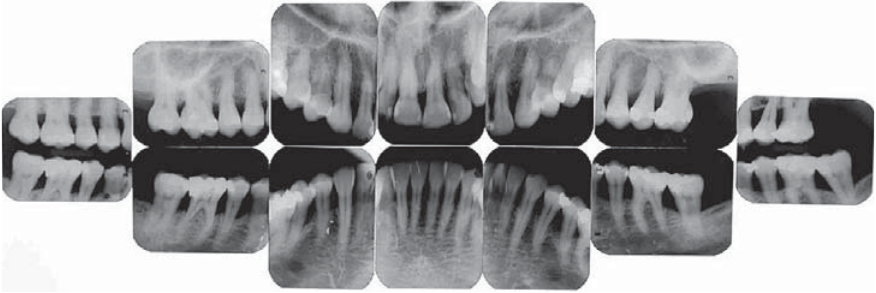
Figure 2- (cid:2) ;(cid:8)(cid:21)(cid:5)(cid:15)"(cid:13)(cid:8)(cid:23)(cid:16)(cid:5)(cid:7)(cid:2) (cid:9)(cid:10)(cid:8)(cid:11)(cid:12)(cid:13)(cid:10)(cid:14)(cid:2) (cid:15)(cid:9)(cid:2) (cid:11)(cid:16)(cid:10)(cid:2) (cid:2) (cid:6)(cid:15)(cid:6)(cid:17)(cid:5)(cid:6)(cid:18)(cid:8)(cid:19)(cid:19)(cid:8)(cid:11)(cid:15)(cid:13)(cid:20)(cid:2) (cid:21)(cid:10)(cid:14)(cid:11)(cid:13)(cid:12)(cid:7)(cid:11)(cid:5)(cid:22)(cid:10)(cid:2) (cid:23)(cid:10)(cid:13)(cid:5)(cid:15)(cid:21)(cid:15)(cid:6)(cid:11)(cid:8)(cid:4)(cid:2) (cid:21)(cid:5)(cid:14)(cid:10)(cid:8)(cid:14)(cid:10)(cid:2) (cid:24)(cid:25)(cid:26)(cid:27)(cid:28)(cid:27)(cid:29)(cid:2) (cid:7)(cid:8)(cid:14)(cid:10)(cid:30)(cid:2) <(cid:23)(cid:23)(cid:8)(cid:13)(cid:10)(cid:6)(cid:11)(cid:2) generalized horizontal alveolar bone loss can be observed in full mouth radiographs